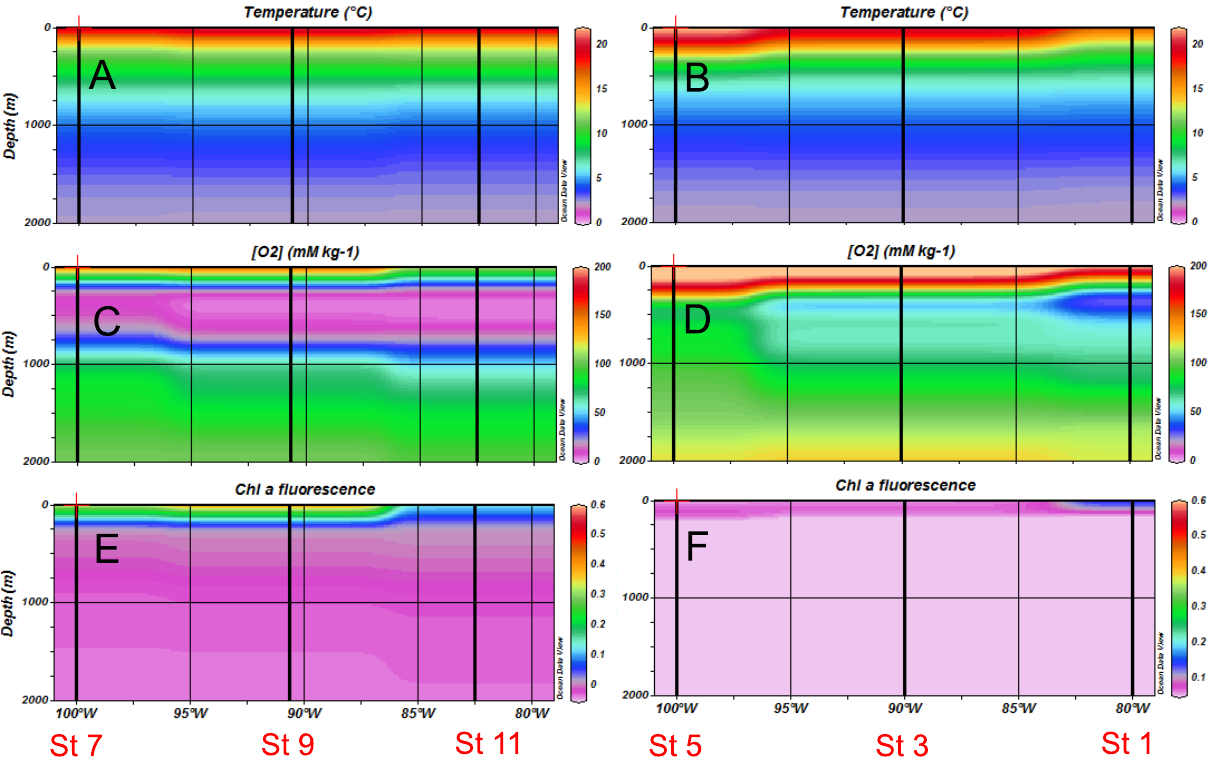
Figure 2. Horizontal and vertical distributions of hydrological and biogeochemical parameters during the 2010 cruise (R/V Atlantis). (A, B) temperature, (C, D) dissolved oxygen, (E, F) chlorophyll fluorescence in the northern transect (left panels) and southern transect (right panels).